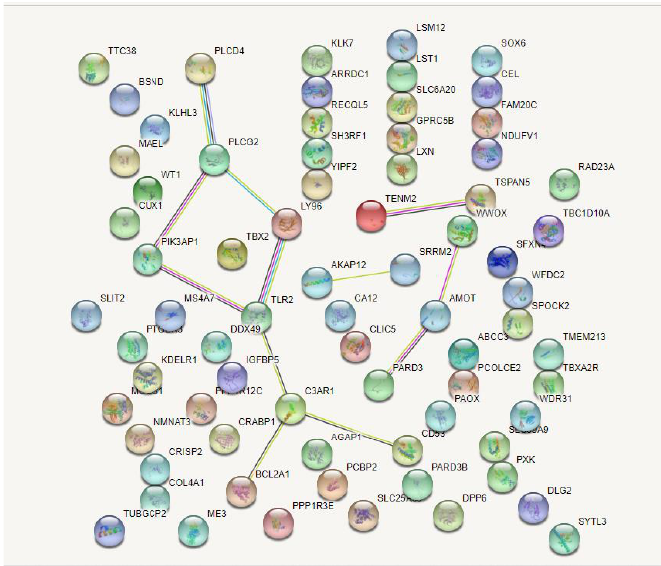
Figure 3. Overall protein – protein interaction network of the 137 identified DEGs. Table 1. Top 10 hub genes with higher degrees of